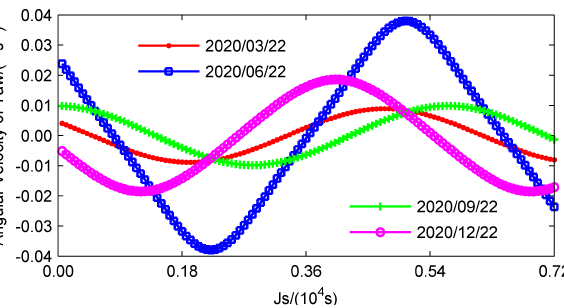
Figure 14. Observed and calculated results of the yaw angular velocity